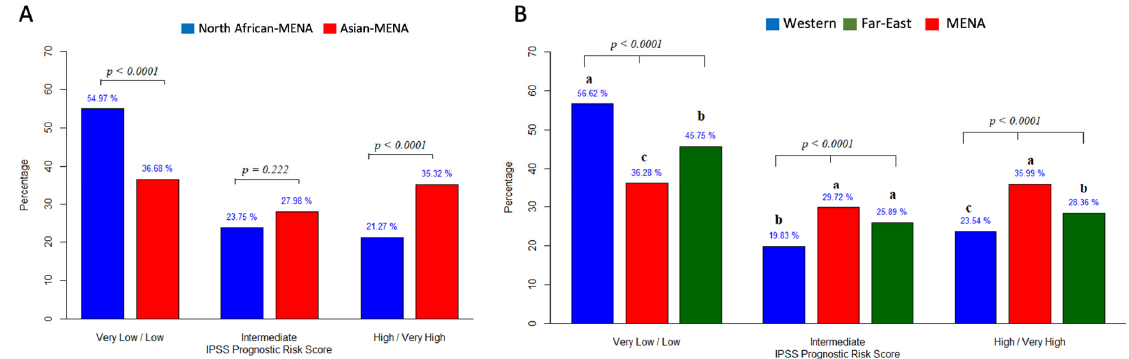
Figure 6. ( A ) Subgroup analysis of the IPSS categories in North African and Asian MENA popula- tions. ( B ) Comparison of IPSS categories between Western, Far East, and MENA populations. We compared our MENA results with results from Western and Far East populations [15]. Letters show significant differences.